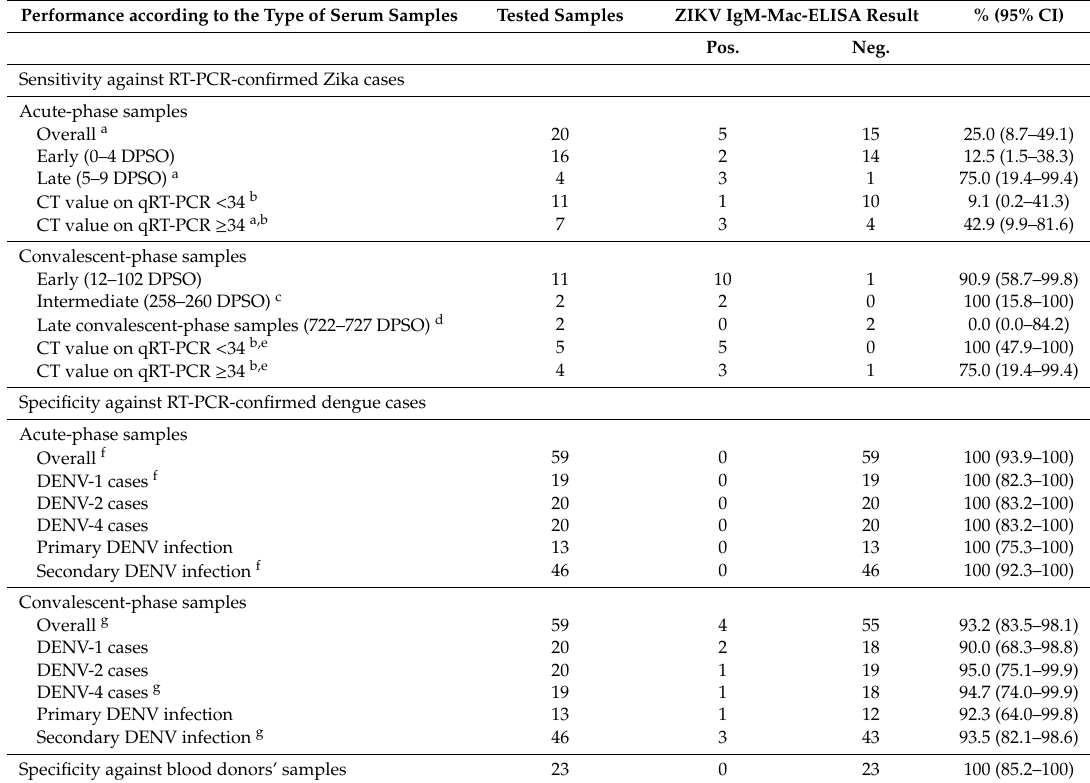
Table 2. Performance of the CDC ZIKV IgM-MAC-ELISA